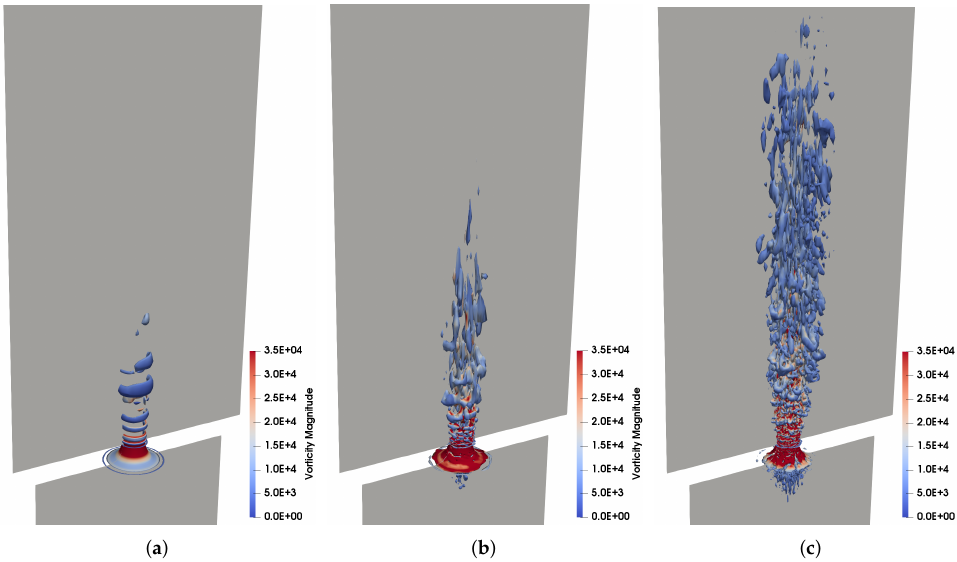
Figure 4. Q Criterion iso-surfaces used to visualise the development of coherent structures in the vicinity of the orifice and in the mixing layer. The initial laminar rings capture the transitional phase as the flow accelerates from a stationary state through the orifice, leading to the appearance of these axisymmetric Kelvin–Helmholtz type rollers, which then develop secondary instabilities as they are convected in the streamwise direction until they breakdown further downstream forming smaller three dimensional turbulent structures. ( a ) Initial laminar instabilities. ( b ) Developing turbulent flow. ( c ) Developed turbulent shear layer.